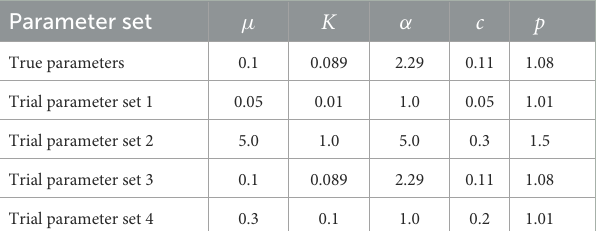
TABLE 3 The true ETAS parameters and the four sets of different initial conditions used in analyzing the catalogs in Figure 3 to produce the ETAS posteriors in Figure